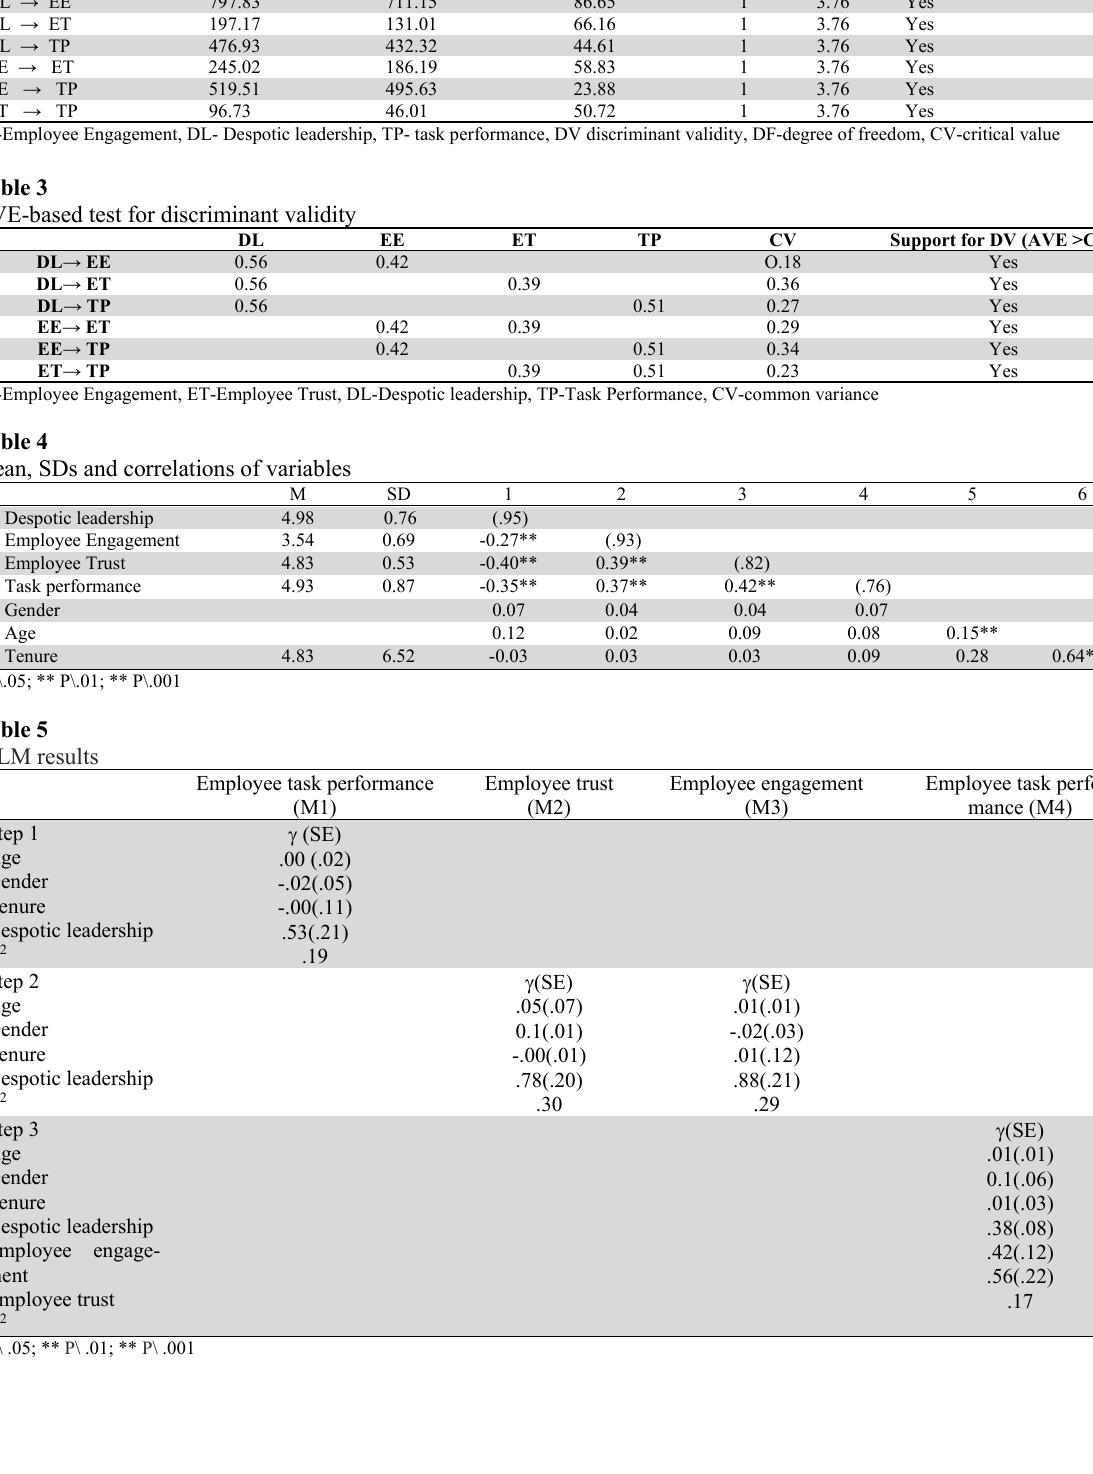
 2 difference test results for discriminant validity  2 values Constrained